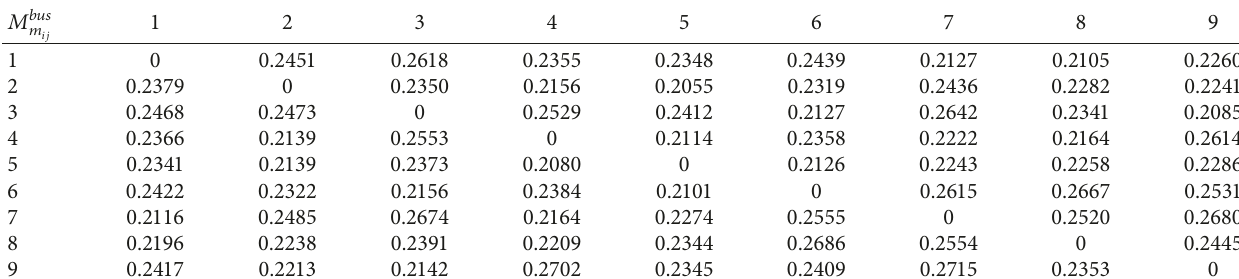
Table 3: The optimal share rate of bus travel in Academy Street historical districts.